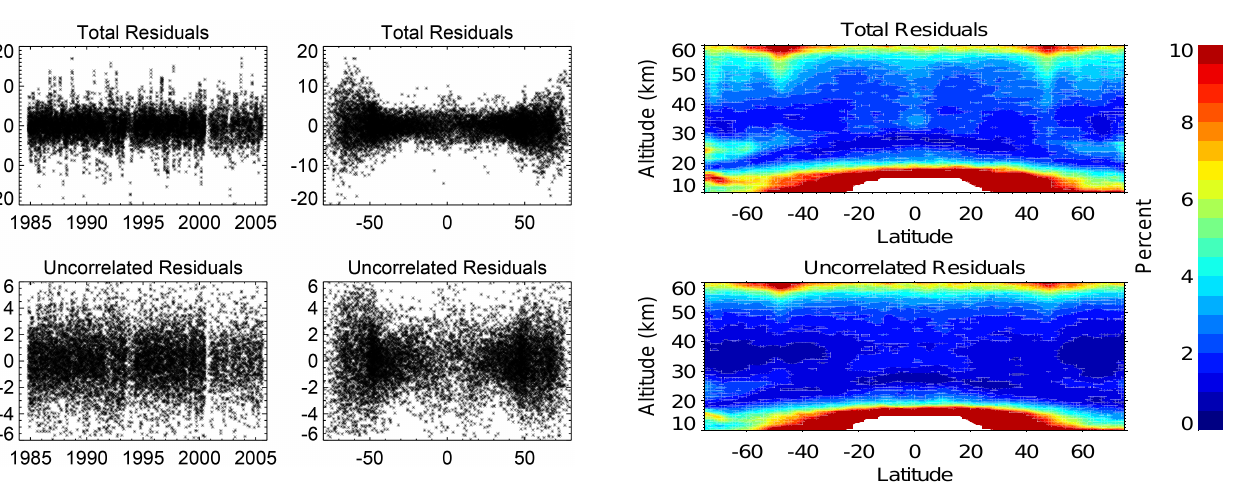
Figure 4. Total and uncorrelated residuals (as percentages) as a Figure 5. Spread of the total and uncorrelated residuals as a function function of both time and latitude at 25km from the STS regression Figure 5. Spread of the total and uncorrelated residuals as a function of latitude and altitude from of latitude and altitude from the STS regression. White regions show (see Eq. B7). Results are similar at other altitudes, though scales the STS regression. White regions show areas where insufficient data exist, generally due to being areas where insufficient data exist, generally due to being in the may change. in the troposphere or early profile termination during retrievals. troposphere or early profile termination during